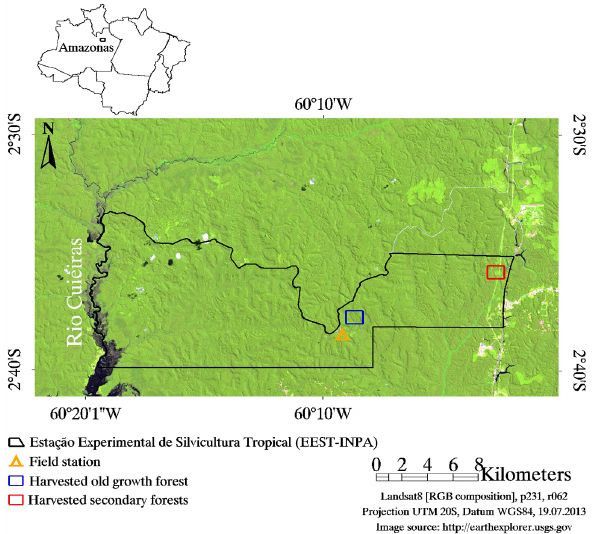
Figure 1. Study site of terra firme forest near Manaus, Amazonas, Brazil.